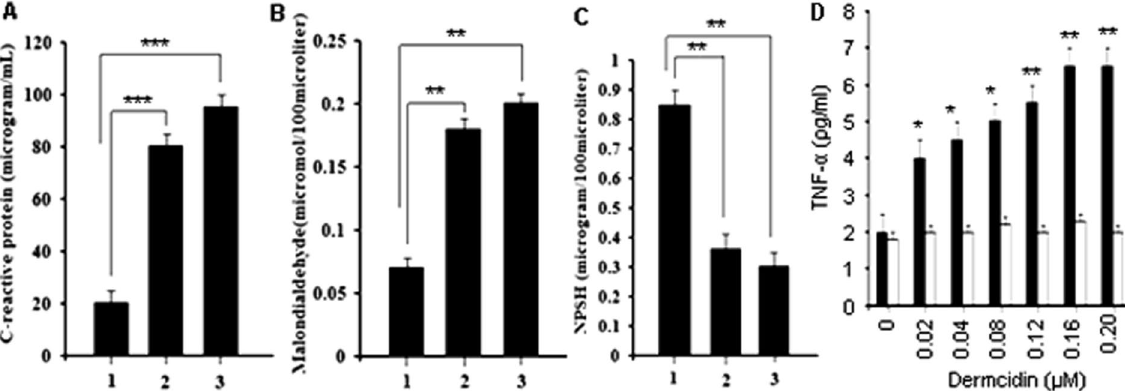
Figure 3. Plasma level of C-reactive protein, malondialdehyde and non-protein soluble thiol in T1DM and normal subjects and DCN-2 induced synthesis of TNF- α in liver cells: The amount of C-reactive protein, malondialdehyde and non-protein soluble thiol present in the CFP of T1DM and normal patients was determined as described in the Materials and Methods. Panel-A: Solid bar ‘1’ represents the amount of C-reactive protein present in the normal volunteers. ‘2’ and ‘3’ represents the amount of C-reactive protein present in the cell free plasma of T1DM volunteers Panel-B: Solid bar ‘1’ represents the amount of MDA present in the normal volunteers. ‘2’ and ‘3’ represents the amount of MDA present in the cell free plasma of T1DM subjects. Panel-C: Solid bar ‘1’ represents the amount of NPSH present in the CFP of normal volunteers. ‘2’ and ‘3’ represents the amount of NPSH present in the cell free plasma of T1DM subjects Panel-D: Solid bars ( ■ ) = DCN-2 induced synthesis of TNF- α in liver cell homogenate, hollow bars ( □ ) = 0.9% NaCl induced synthesis of TNF- α in liver cell homogenate. ( * Represents p < 0.05, ** represents p < 0.001, *** represents p < 0.0001).